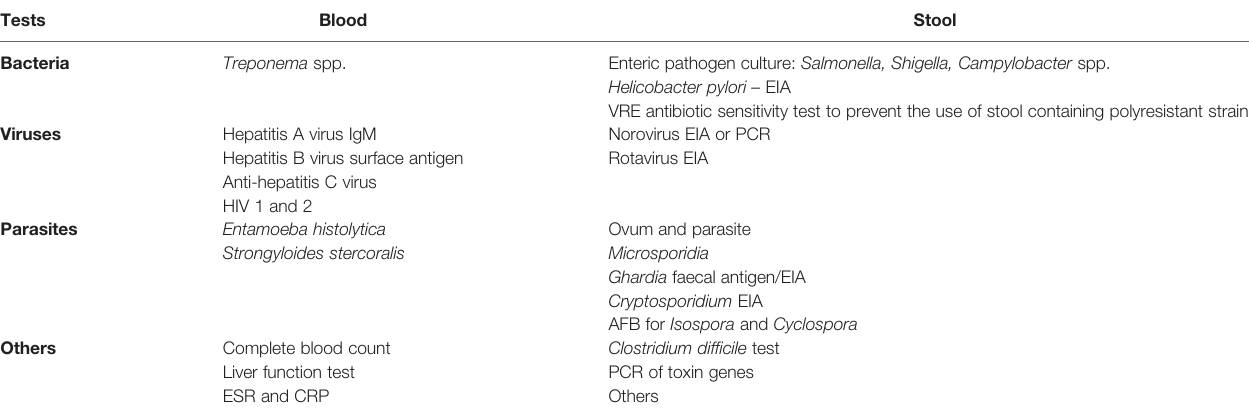
TABLE 2 | Suggested laboratory tests for potential donors for faecal microbiota transplantation. Tests Blood Stool